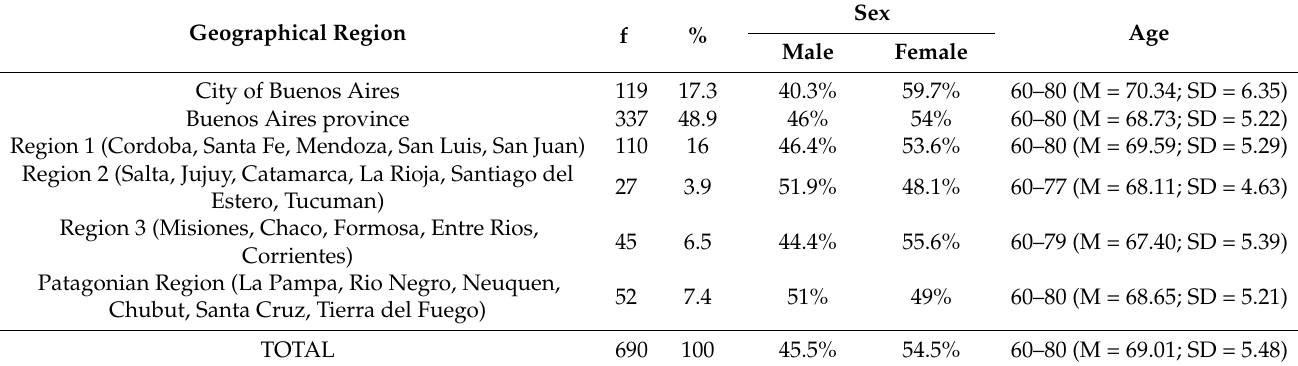
Table 1. Distribution of Cases per Region of